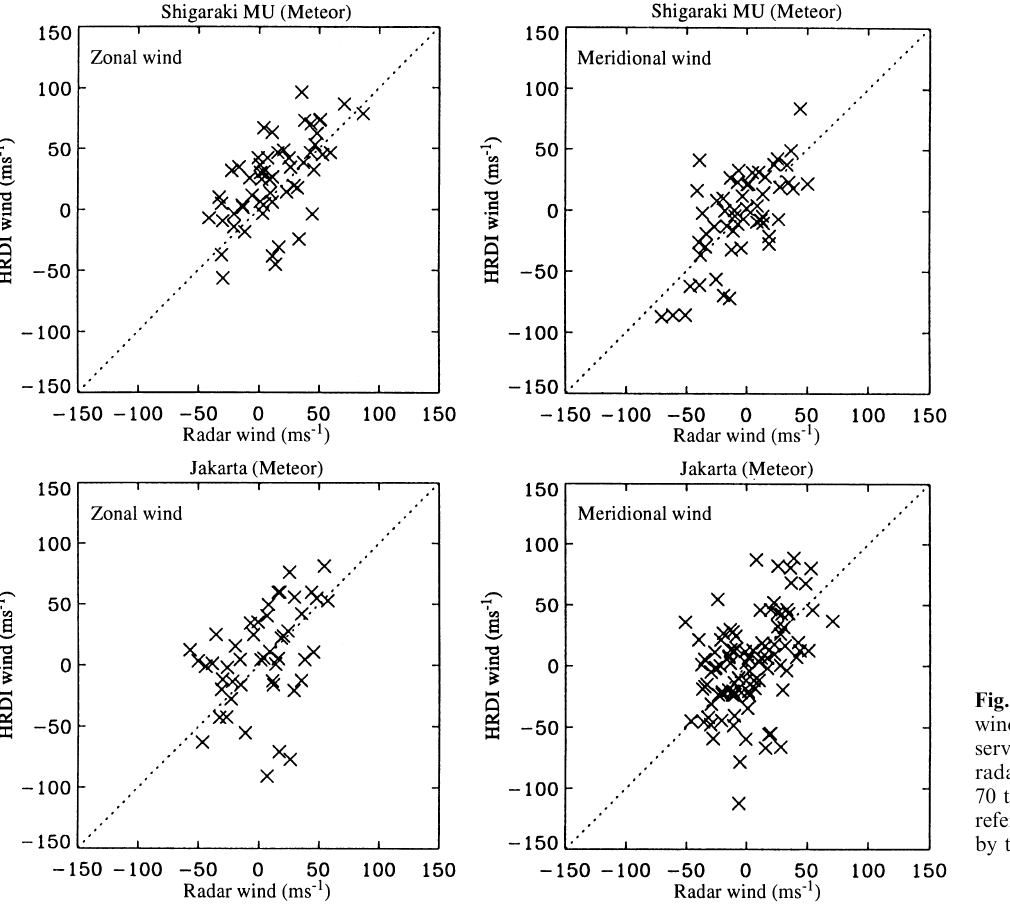
Fig. 3. Scatter plots of the wind velocity components ob- served by HRDI and meteor radars in the altitude range of 70 to 100 km. Broken lines are references for equal velocities by